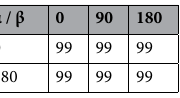
Table 2. Number of surfaces in the